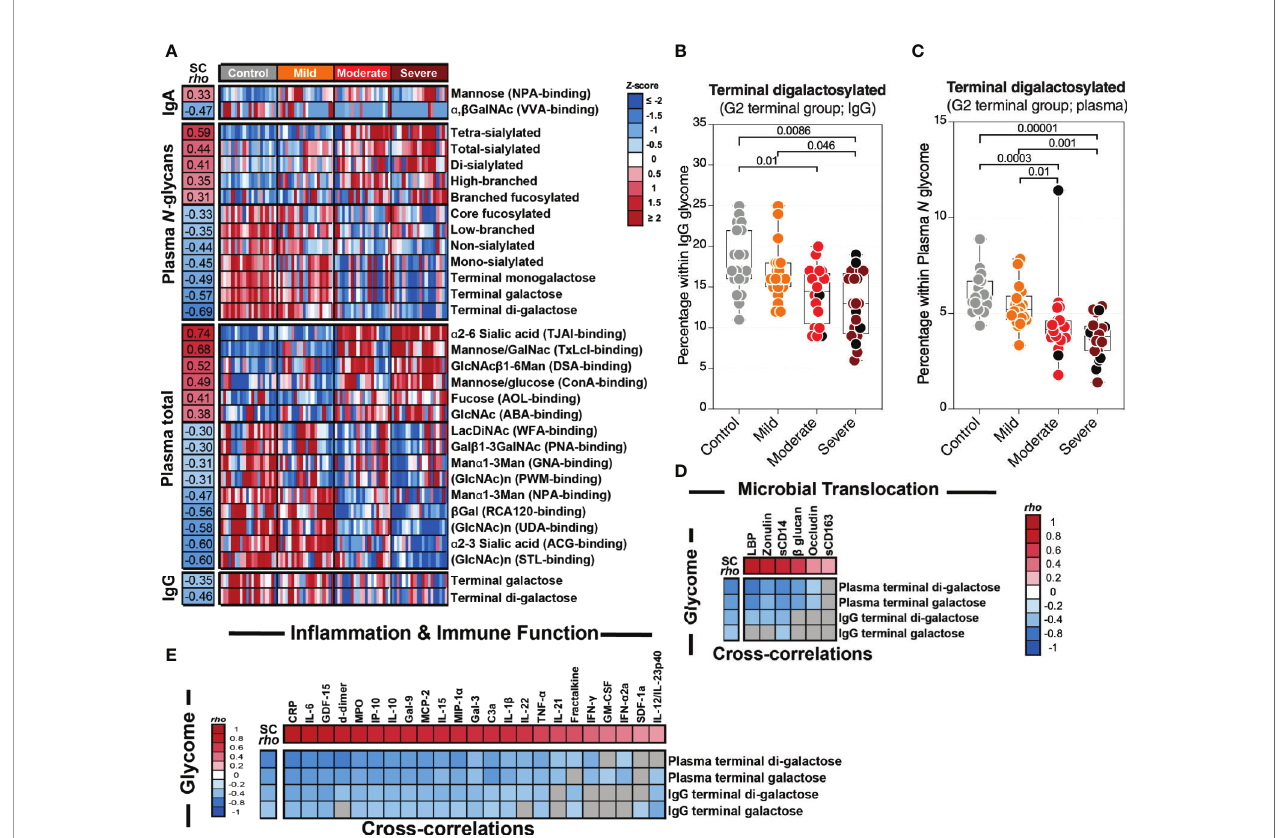
FIGURE 6 | Severe COVID-19 is associated with plasma glycomic dysregulations. (A) Heat-map depicting glycans dysregulated by severe COVID-19 (FDR<0.05). Names of the glycan-binding lectins are provided in parentheses. Statistical signi fi cance was determined using the Kruskal – Wallis test. FDR was calculated using Benjamini-Hochberg method. SC rho = coef fi cient of correlation with COVID-19 severity. Heat colors show standardized Z-scores across samples; red indicates upregulation, and blue indicates downregulation. (B, C) Levels of terminal digalactosylated N -glycans in IgG (B) or total plasma glycoproteins (C) are lower during severe COVID-19 compared to mild COVID-19 or controls. Kruskal – Wallis test. FDR was calculated using Benjamini-Hochberg method. (D, E) Correlation heat-maps depicting the correlations between galactosylated N -glycans (rows) and markers of tight junction permeability and microbial translocation (D) or markers of in fl ammation and immune dysfunction (E) . SC rho = coef fi cient of correlation with COVID-19 severity. Red-colored correlations = signi fi cant positive correlations with FDR<0.05, blue-colored correlations = signi fi cant negative correlations with FDR<0.05, and gray-colored correlations = non-signi fi cant. Spearman ’ s rank correlation tests were used for statistical analysis. FDR was calculated using Benjamini-Hochberg method. Black dots indicate